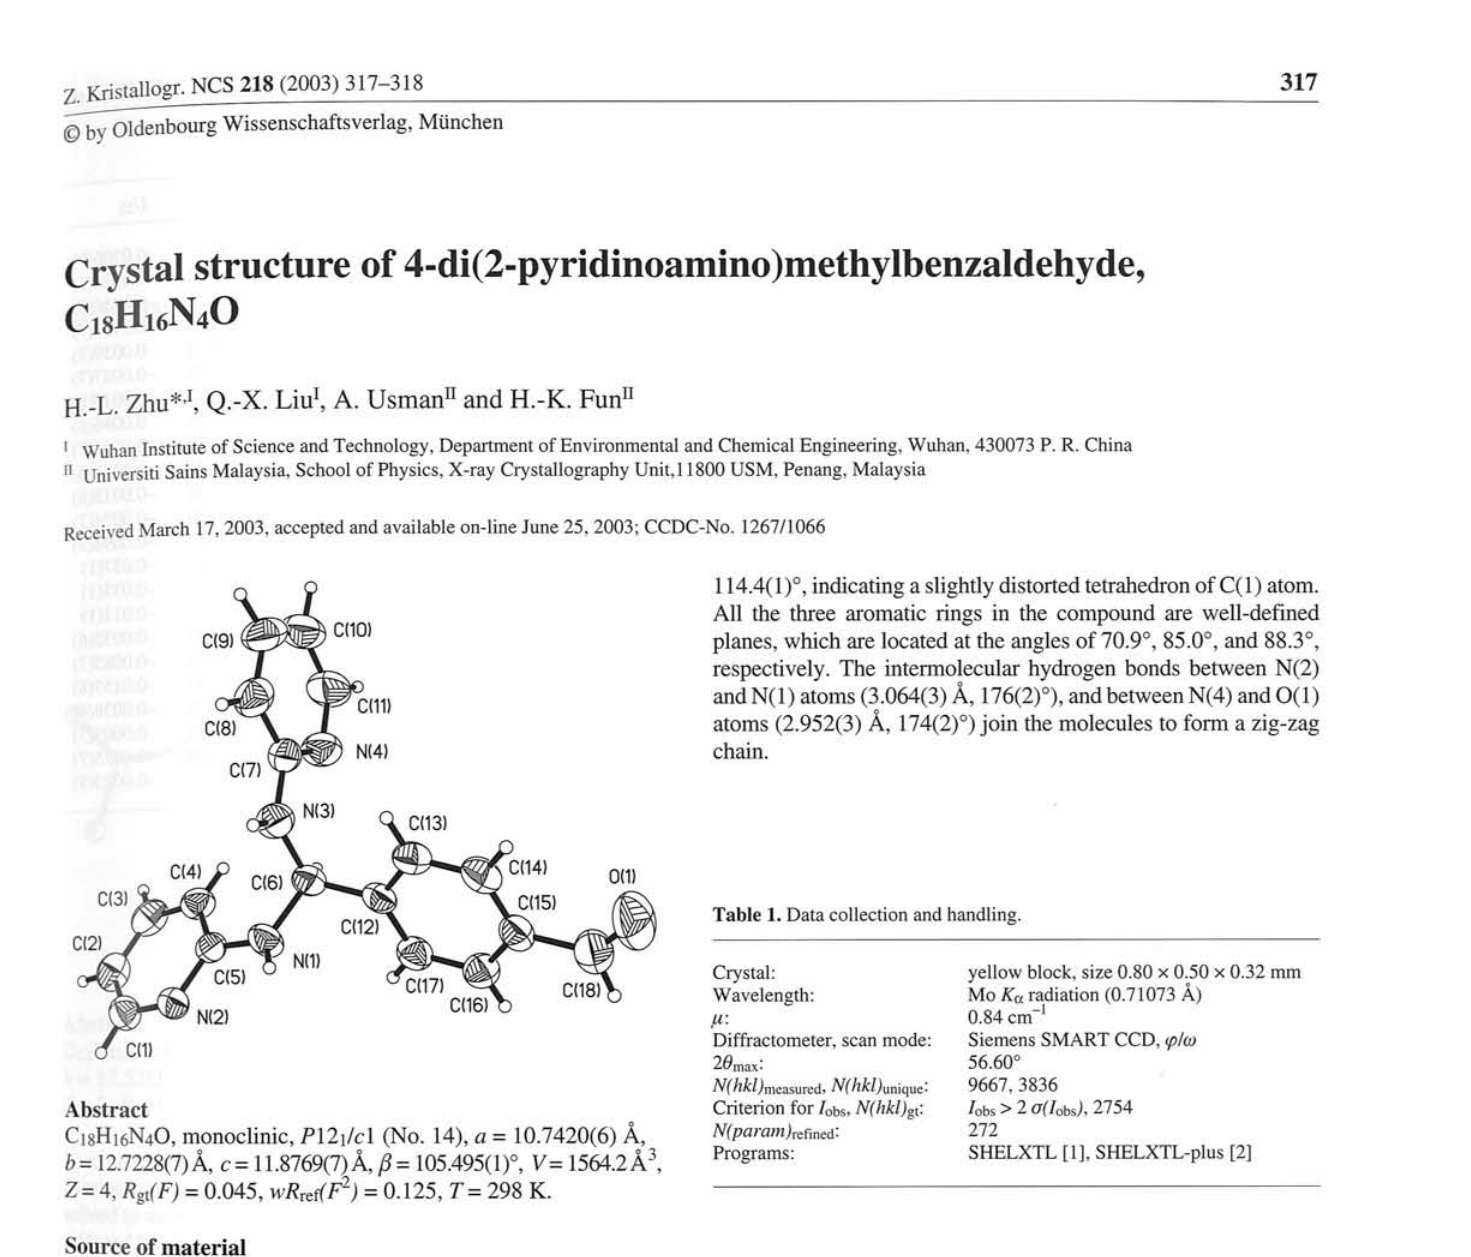
Table 2. Atomic coordinates and displacement parameters (in